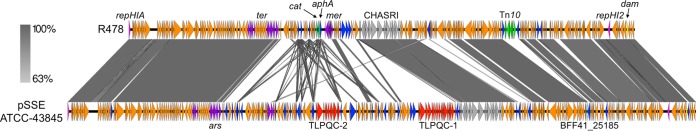
BLASTN comparison of the R478 and pSSE ATCC-43845 plasmids. The backbone for R478 is highly conserved in pSSE ATCC-43845. The majority of differences between the two plasmids reside between the tellurite resistance island and CHASRI (copper homeostasis and silver resistance island). The lack of any known antibiotic resistance genes, such as aphA (kanamycin) or cat (chloramphenicol), on pSSE ATCC-43845 is also noted. The integration site for Tn10 with tetracycline resistance is in BFF41_25185 in pSSE ATCC-4384. Heavy metal resistance genes (purple), antibiotic resistance genes (teal), TLPQC genes (red), transposase genes (blue), CHASRI genes (silver), and rep (magenta) and the mercury resistance (mer), methylase (dam), tellurite resistance (ter), arsenic resistance (ars), and replicase (rep) genes are indicated.